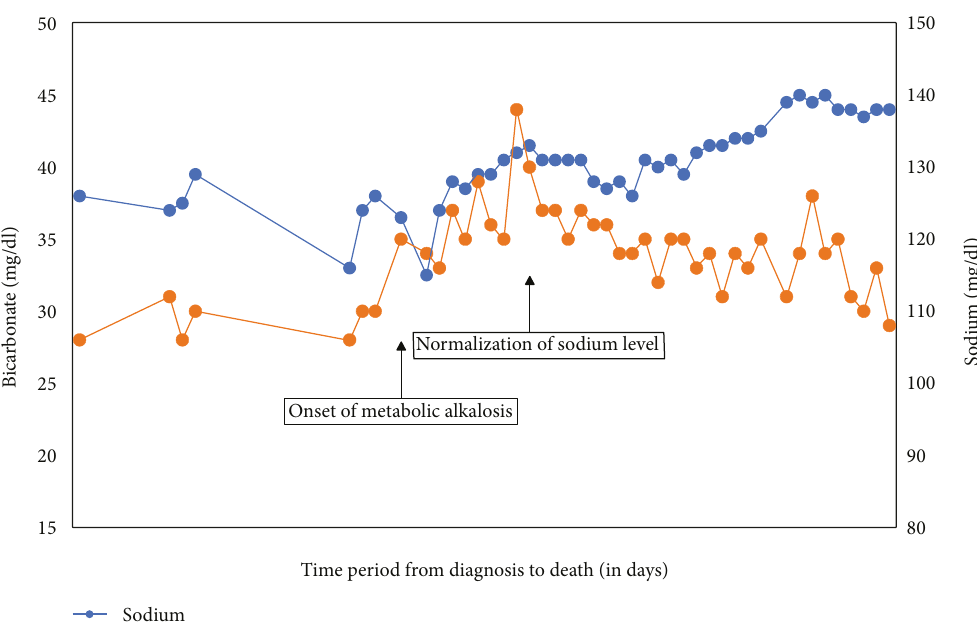
Figure 2: Graph showing serum sodium (blue) and bicarbonate levels (orange) from diagnosis to patient ’ s demise. Note how serum sodium normalizes with onset of metabolic